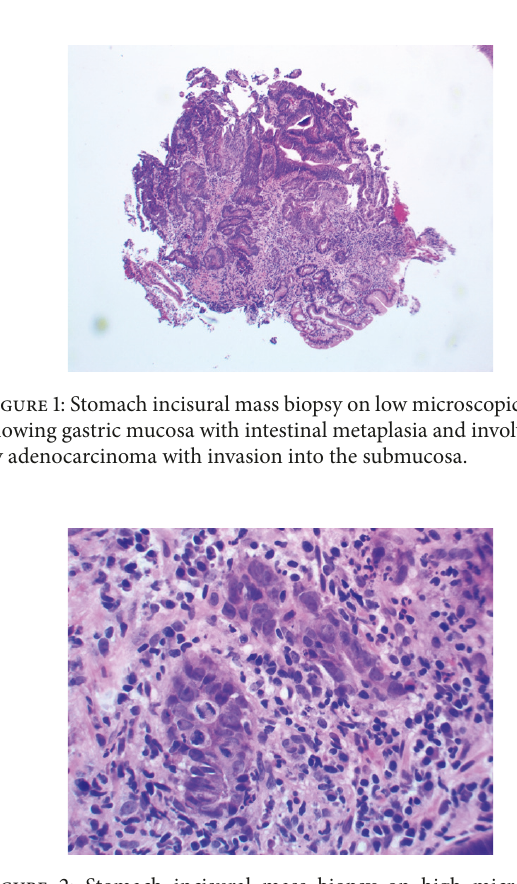
Figure 2: Stomach incisural mass biopsy on high microscopic power showing disorganized groups of pleomorphic cells with nuclear atypia, large nucleoli, and mitotic